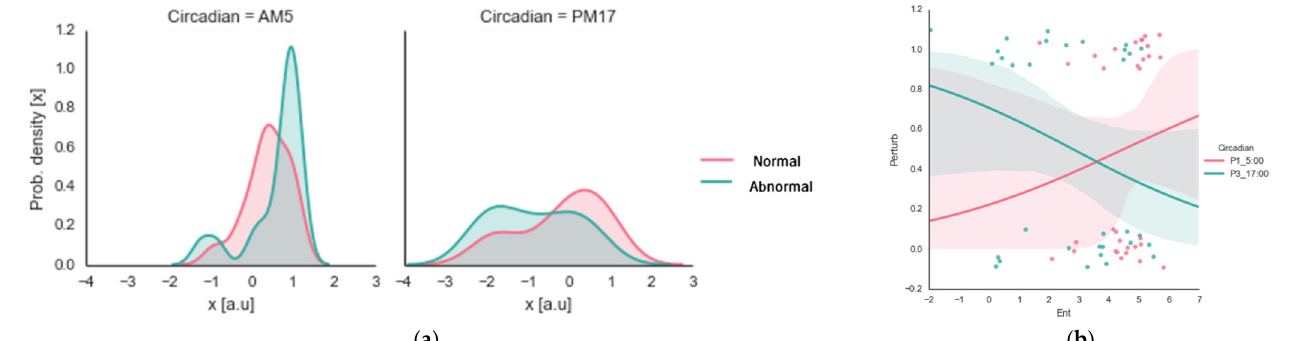
Figure 5. Circadian and temperature perturbation (ice-based) dependent influences: ( a ) shows the data double-plotted with the variation in a histogram and the kernel density function (vertical_axis = probability density, horizontal_axis = entropy production; False = normal, True = perturbation; Circadian AM = 5:00 in the morning, Circadian PM = 5:00 in the afternoon); ( b ) shows the relationships between the entropy (horizontal axis) and perturbation (vertical axis) for the different circadian points (red line and dots denote 05:00 h, blue line and dots denote 17:00 h).